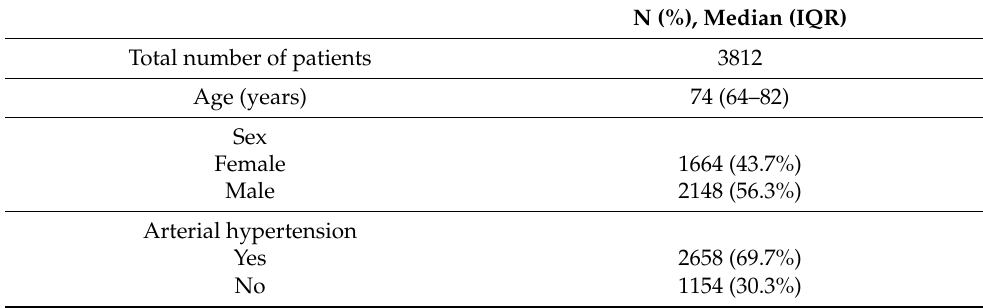
Table 1. Characteristics of the analyzed cohort of patients with COVID-19 at admission to